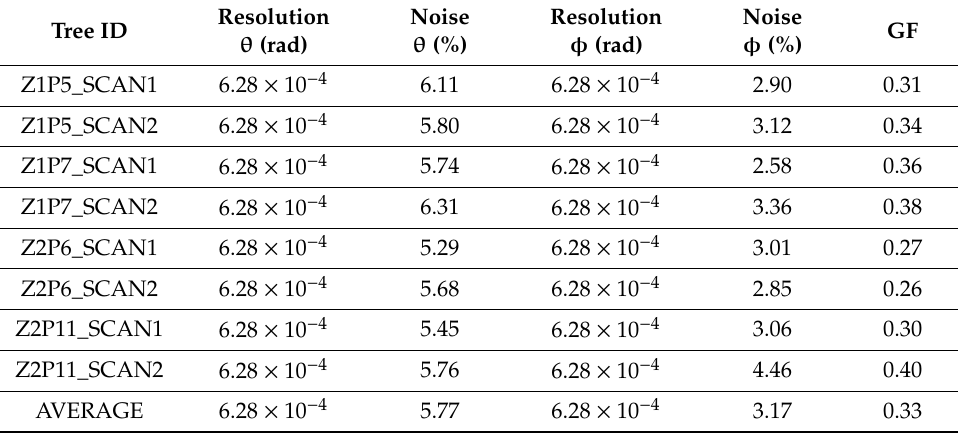
Table 3. Tree ID, angular resolution, noise and GF for TLS tree data. Tree ID